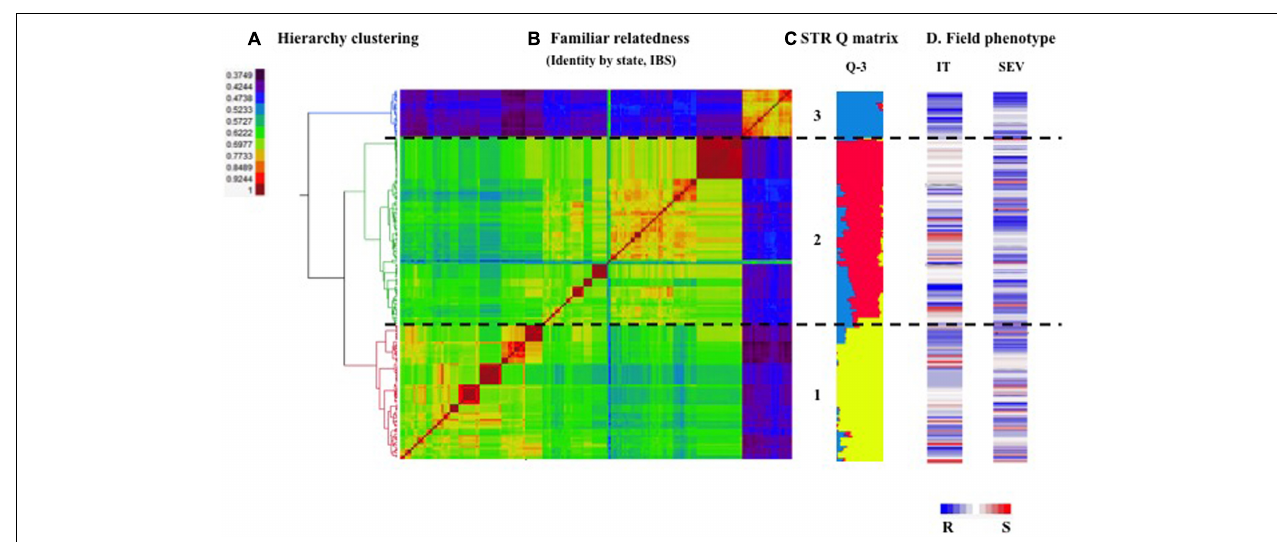
FIGURE 2 | Population structure of 182 Ethiopian durum wheat accessions. (A) Hierarchy cluster analysis of 182 Ethiopian durum landraces using the method of identity-by-state (IBS) algorithm. (B) Heat map of kinship matrix using the IBS method. Horizontal dashed line divided the 182 accessions into three subpopulations based on the hierarchy clustering on the left. (C) Bar plot of the population structure. Accessions in (A,B) were arranged according to the order of kinship heat map. The colored lines represent the membership of each accession in the STRUCTURE-inferred subpopulations. (D) Heat map of stripe rust responses [best linear unbiased predictors for infection type (IT) and disease severity (SEV) across six environments] in the field. Blue to white to red lines show resistance to intermediate to susceptibility to stripe rust of the corresponding accessions.